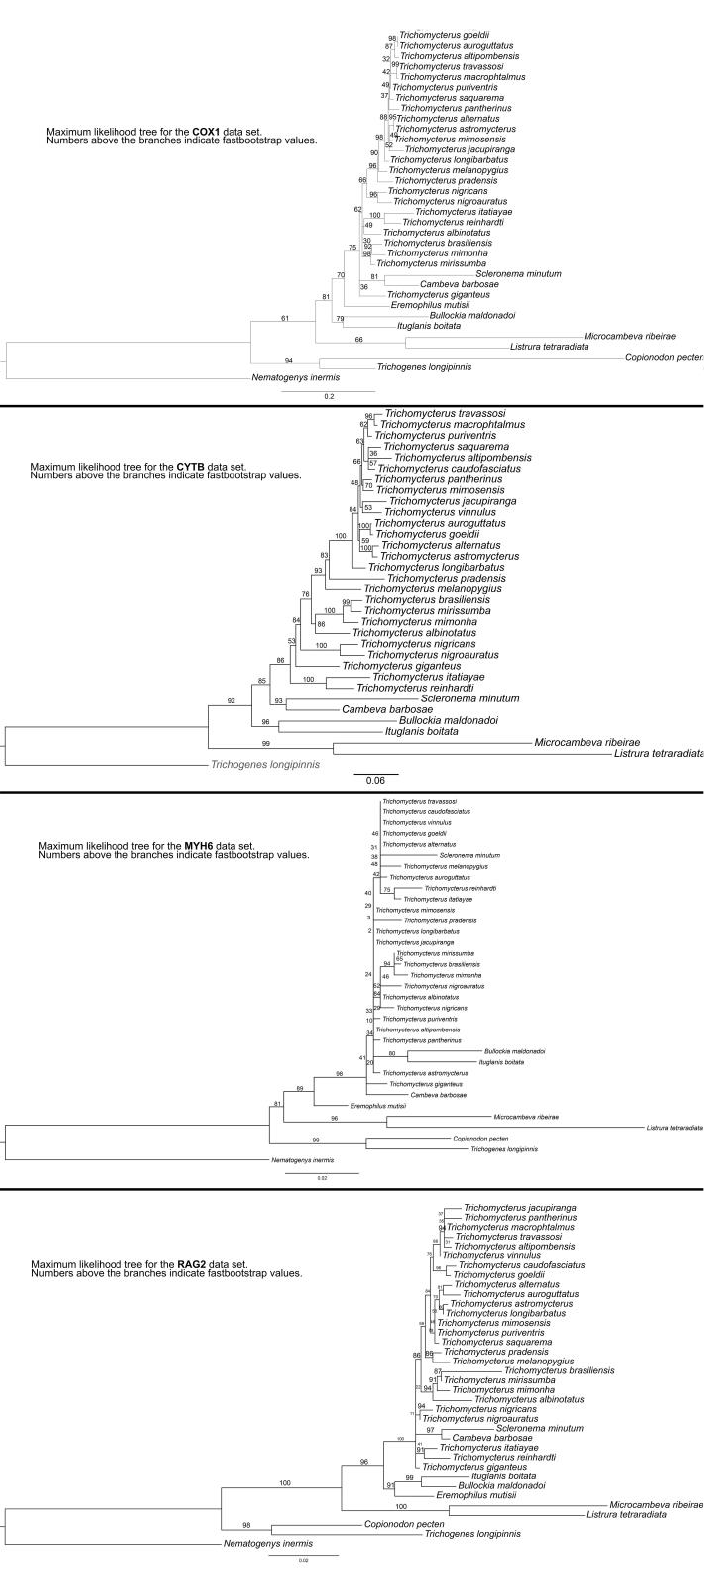
Figure A1. Genes trees generated by IQTree.